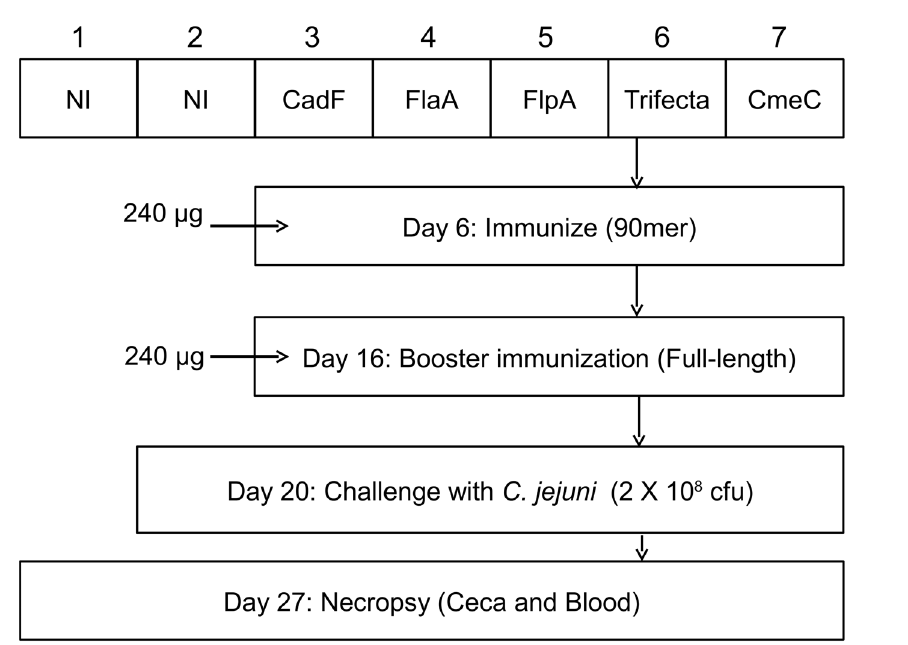
Figure 3. Experimental design of chicken vaccination experiment. The first peptide injections were given at a dose of 240 m g (GST-CadF, GST-FlaA, GST-FlpA, GST-CmeC, and the CadF-FlaA-FlpA GST-trifecta groups) and the booster injections were given at a dose of 240 m g (CadF-His, FlpA-His, GST-FlaA, GST- CmeC, and CadF-FlaA-FlpA GST-trifecta). Groups 1 and 2 were not injected with a C. jejuni SECP (NI 5 no injection). Each chicken within Groups 2 through 7 received a dose of 2 6 10 8 CFU of C. jejuni at day 20. The chickens were necropsied at 27 days of age.